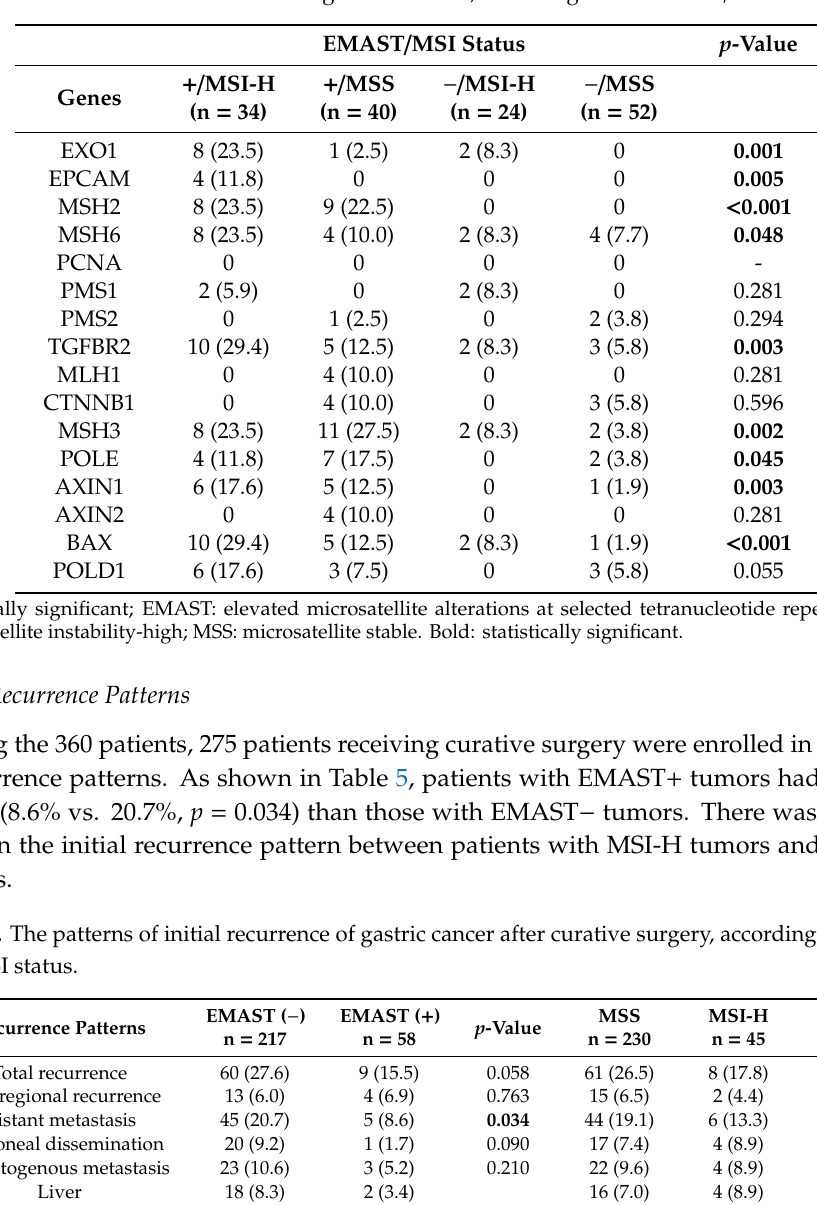
Table 4. Genetic mutations using NGS method, according to the EMAST / MSI status.